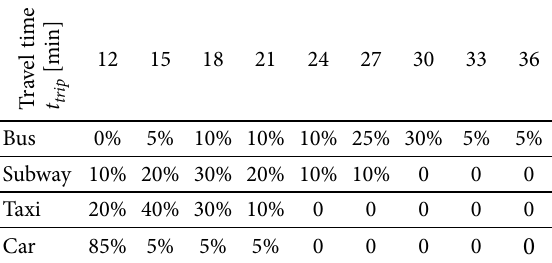
Table. 2 Traveller’s estimation on different modes’ travel